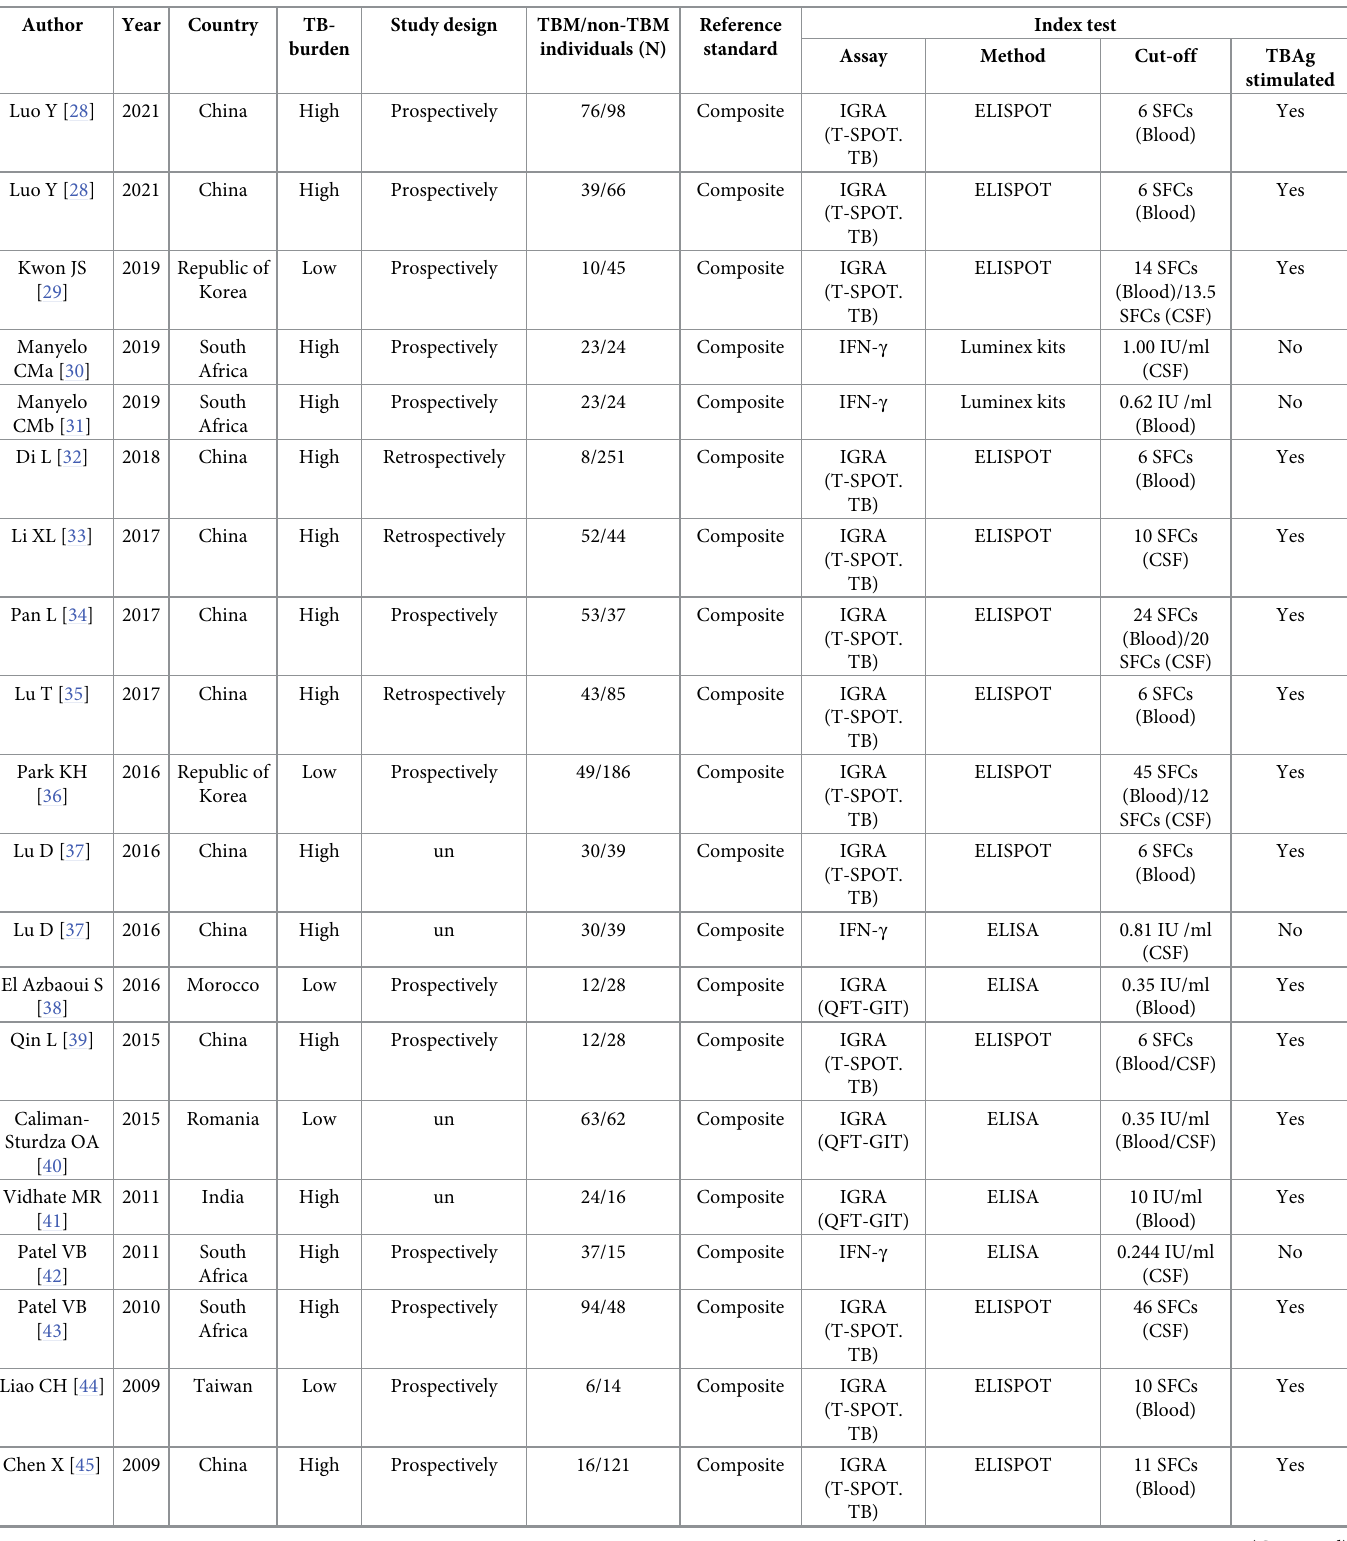
Table 1. Characteristics of the included